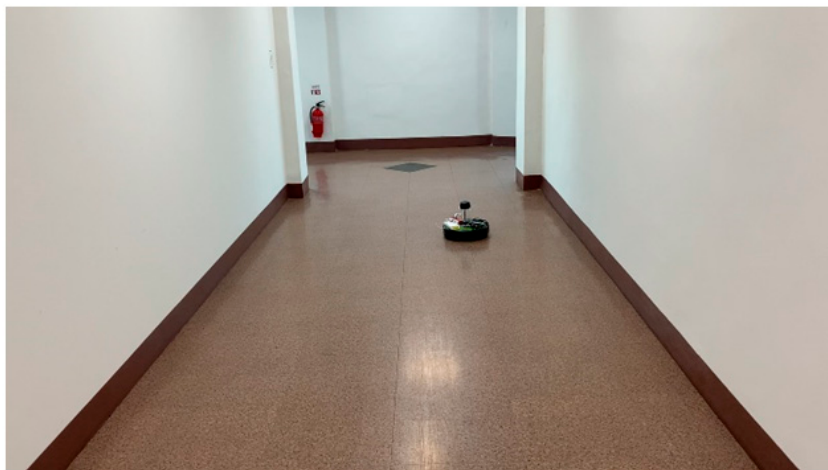
Figure 30. Position (marked 2 in Figure 29) in indoor space where third autonomous scanning experiment was performed.